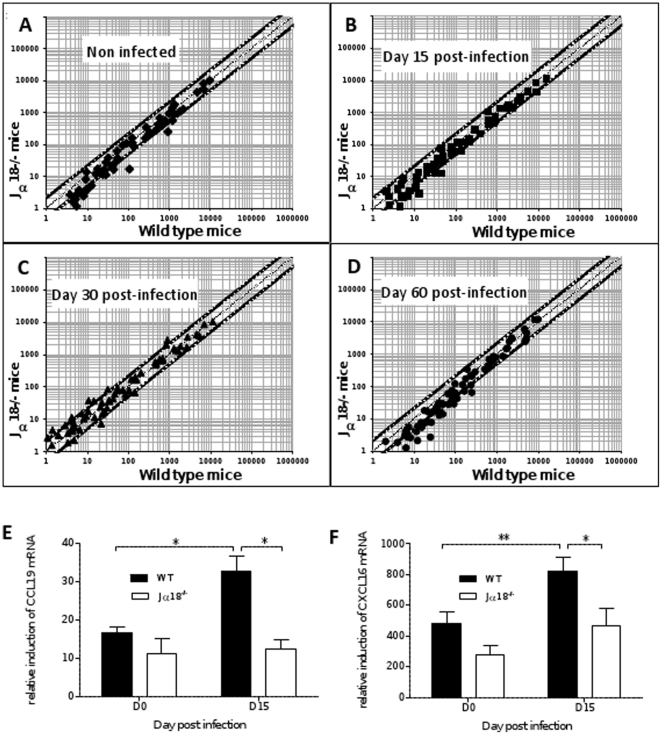
Hepatic transcriptome of cytokines and receptors is altered in Jα18-/- mice.Graphs represent the ratio of genes induction in Jα18-/- mice compared to WT, after normalization on three housekeeping genes, at day 0 (non infected) (A), day 15 (B), day 30 (C) or day 60 (D) after infection, with the central 45° angle line indicating a same level of induction in both backgrounds of mice and the two border lines corresponding to a 2-fold induction in one or the other group of mice. Data are the mean±SEM of triplicate samples pooled from 8 to 10 mice from two independent experiments. Quantification of mRNA of the T cell-chemoattractant chemokines CCL19 (E) and CXCL16 (F) in liver extracts of naïve WT and Jα18-/- mice, 15 days after infection. Data represent mRNA induction normalized on three housekeeping genes, and are the mean±SEM for each group of mice (8–10 mice per group from two independent experiments).